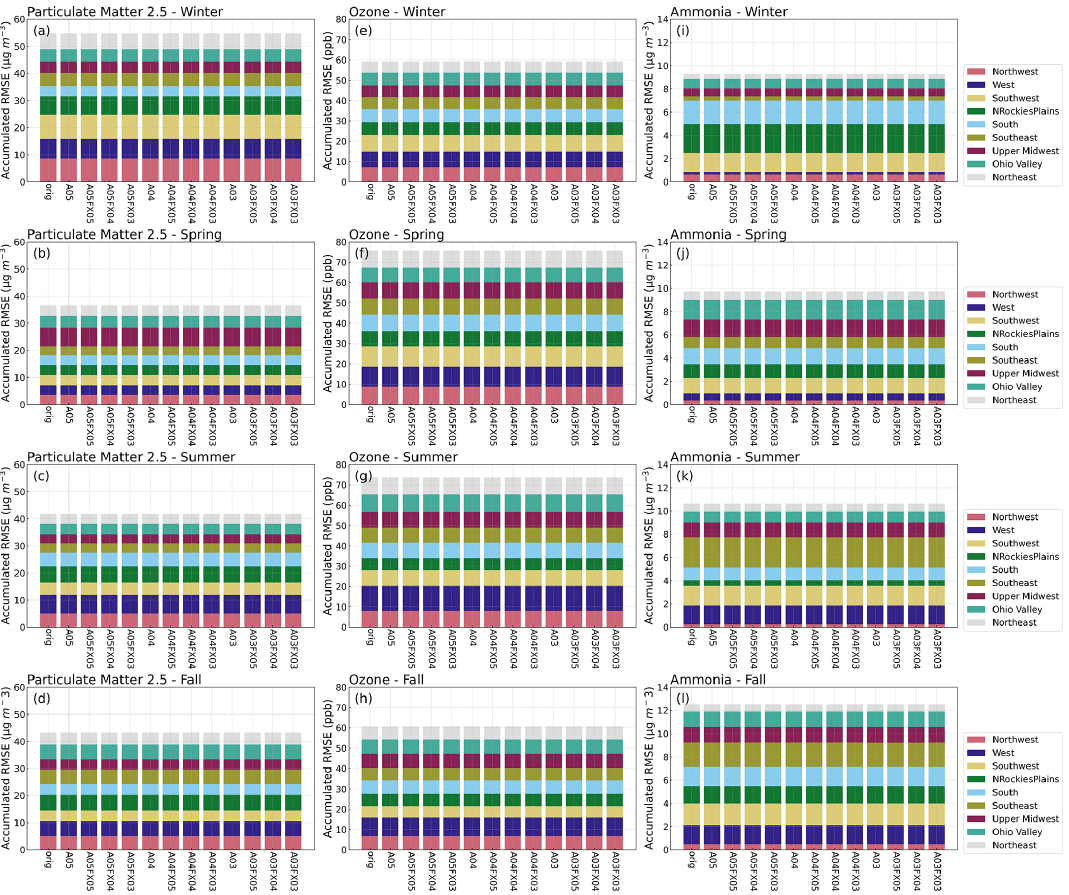
Figure 5. Stacked bar plots of RMSE ( y axis) stratified by region (color), simulation and case ( x axis), and season (subplot) for daily PM 2 . 5 , MDA8 O 3 , and 2-week-averaged NH 3 calculated from in situ observation.